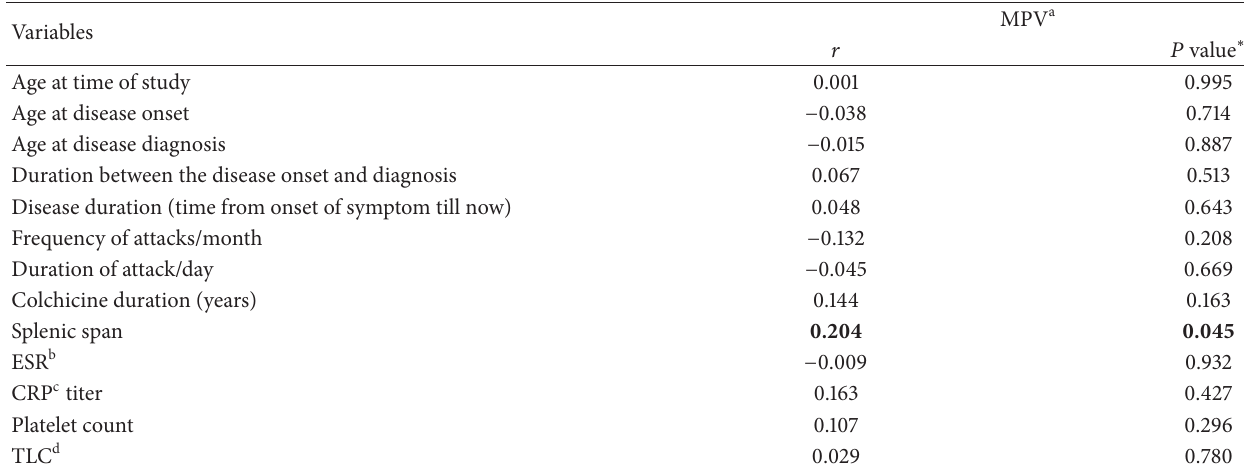
Table 3: Statistical correlations between MPV and variable